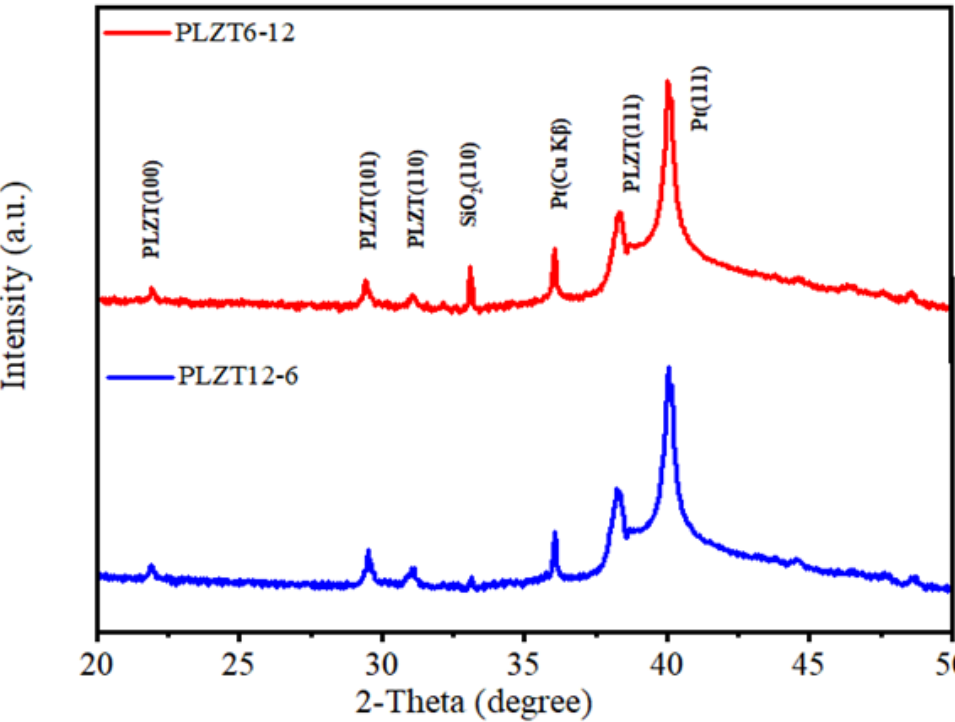
Figure 2. XRD patterns of the up-graded and down-graded PLZT thin films.